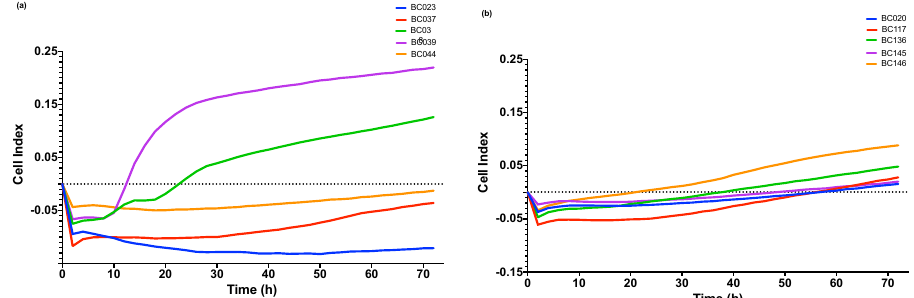
Figure 3. Viability percentage of biofilms in relation to untreated biofilms after treatment with NaOCl and reincubation with fresh Roswell Park Memorial Institute (RPMI) media. Immediate post-treatment (0), 24, 48 and 72 h for LBF (upper line) and HBF (lower line). Values represent the mean with standard Figure 4 error of the mean (SEM) from three independent experiments.